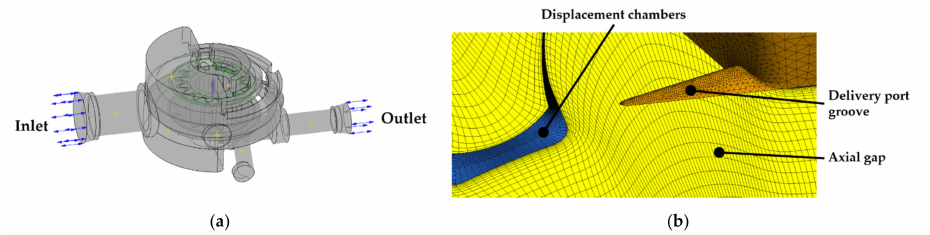
Figure 7. Full CFD model with BCs ( a ) and meshing details of the axial gap and the delivery port groove ( b ) of the